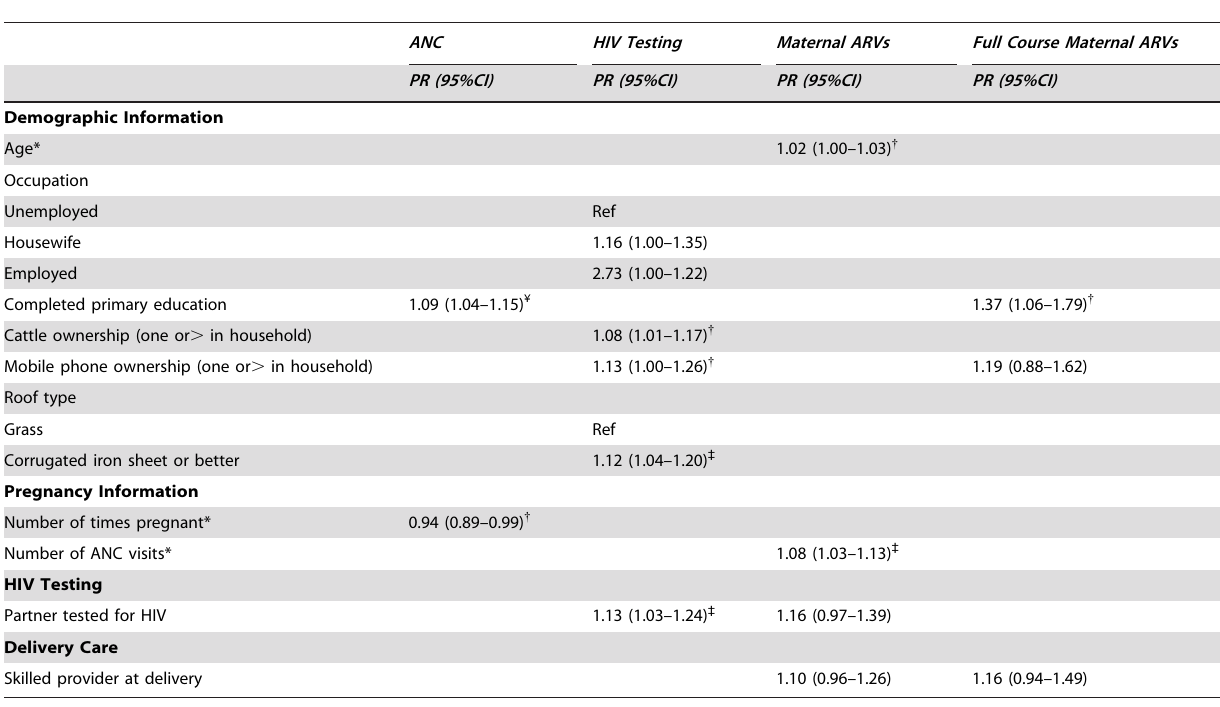
Table 4. Summary of Adjusted Prevalence Ratios (PR) for Accessing Steps of PMTCT